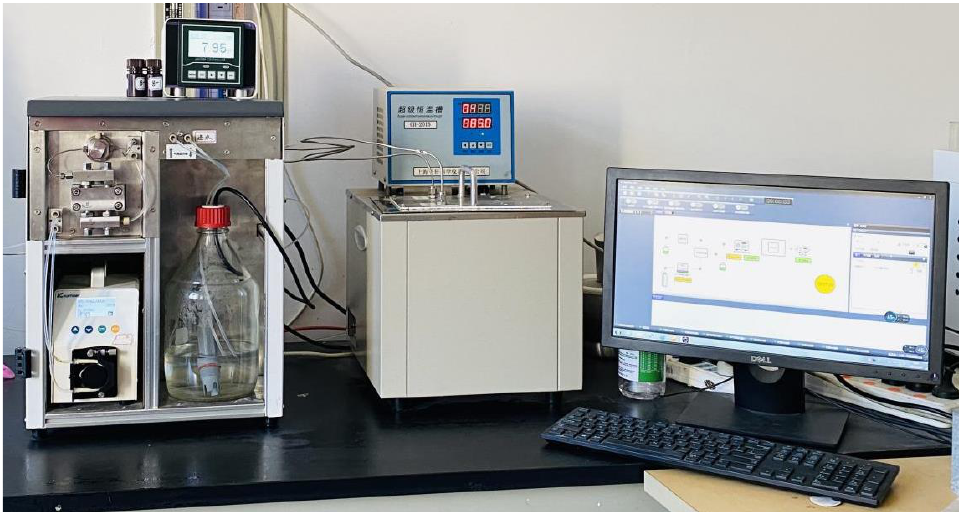
Figure 3. Self-made YDYR-2 rock hydrodynamic pressure dissolution test equipment [7].